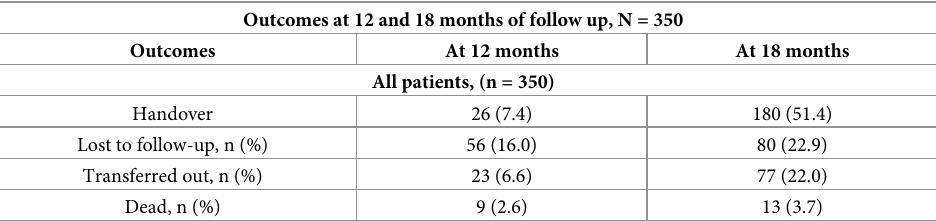
Table 2. Patients’ outcomes at 12 and 18